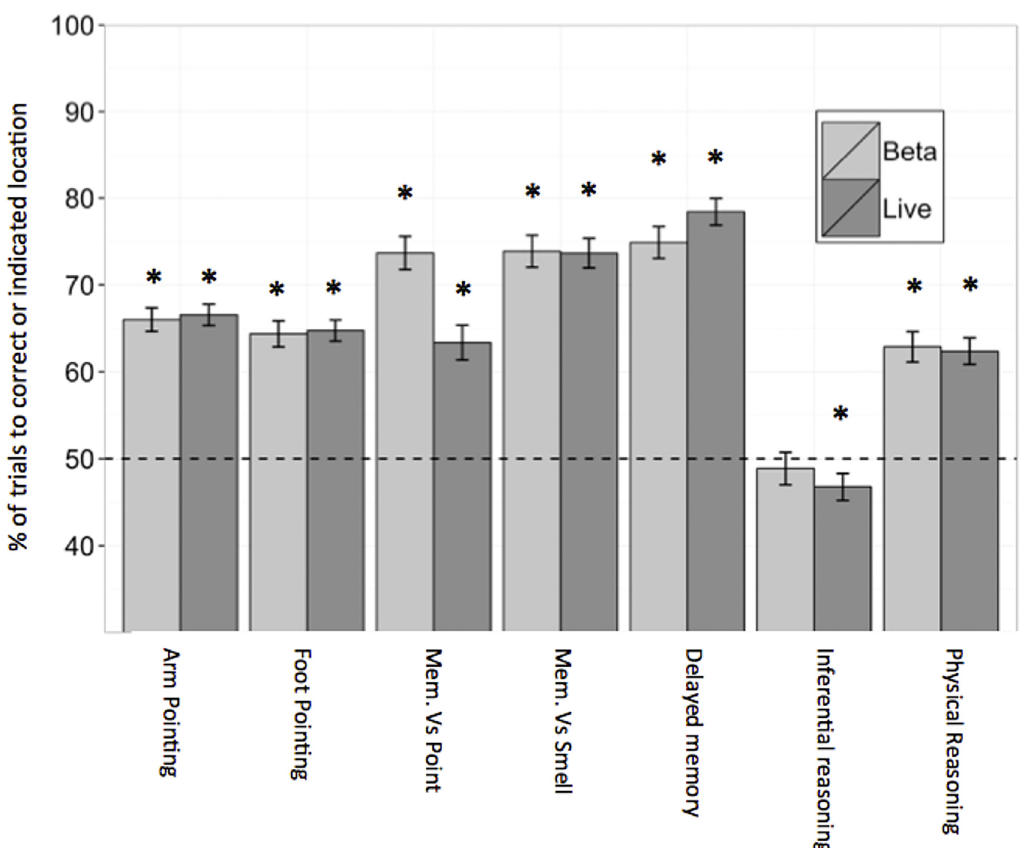
Fig 2. Mean performance (+/- SEM) in each task in which dogs faced a two way choice with chance being 50%. In the memory exercises (Mem Vs. Point and Mem Vs. Smell) success was scored when a dog made a choice consistent with relying on their memory (i.e. not a gesture or olfactory cues). Light grey bars represent Beta and dark grey representing Live datasets. * < 0.05 binomial probability.